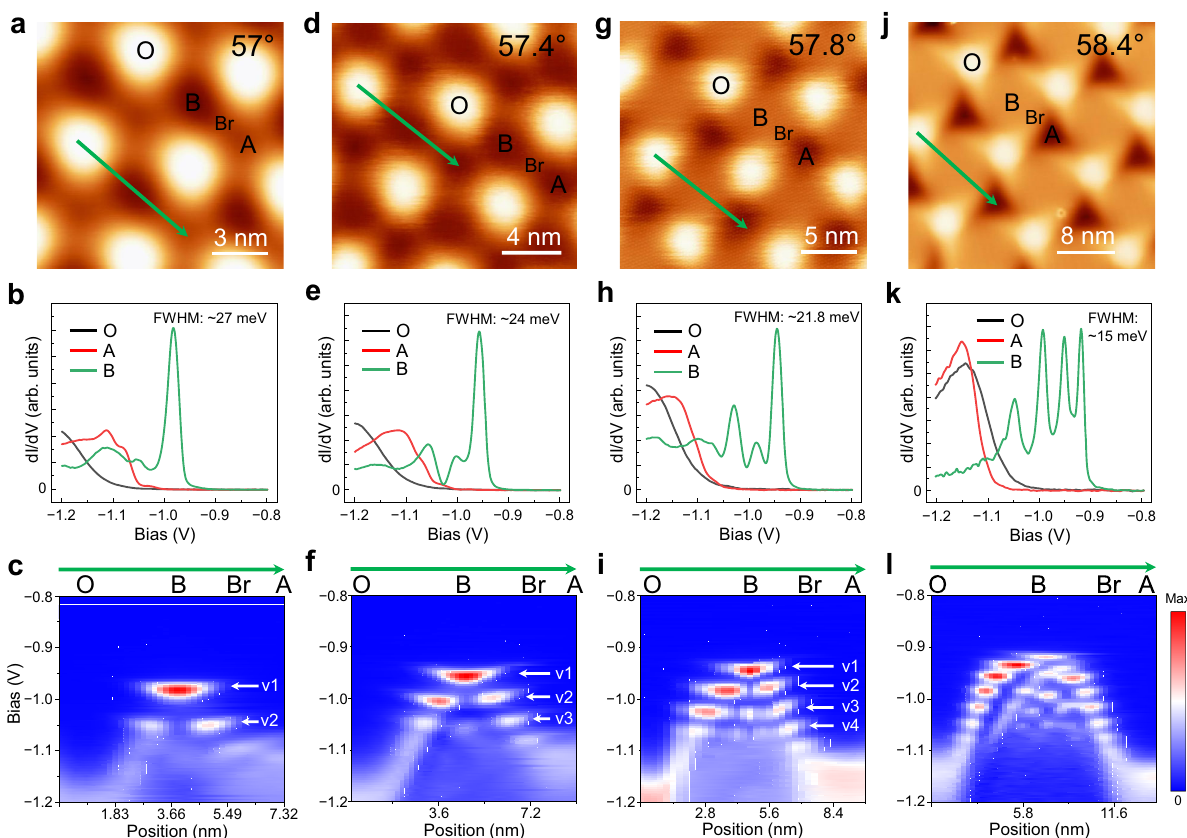
Fig. 2 Spatially dependent spectroscopy of 57°, 57.4°, 57.8°, and 58.4° TB-WSe 2 . a An STM topographic image ( − 1.4 V, 1.0 nA) of 57° TB-WSe 2 . b d I / d V spectrums near VB edge acquired at the center of three moiré sites, V = − 1.4 V, I = 1 nA, V mod = 10 mV. The FWHM is extracted from a Gaussian fi t applied to the data. c Conductance map taken along the green line in panel a , revealing two B-con fi ned states (marked by white arrows). Similarly, d – f